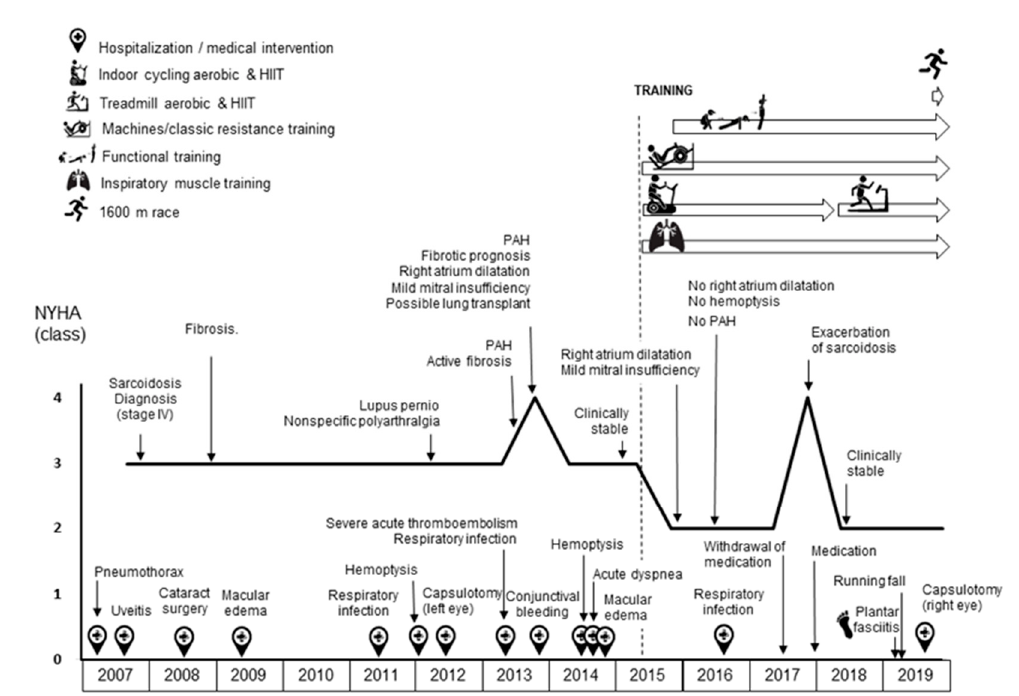
Figure 1. Graphical Abstract. Clinical and functional evolution of the patient since diagnosis of sarcoidosis. Abbreviations: HIIT, high-intensity interval training; NYHA, New York Heart Association; PAH, pulmonary arterial hypertension.